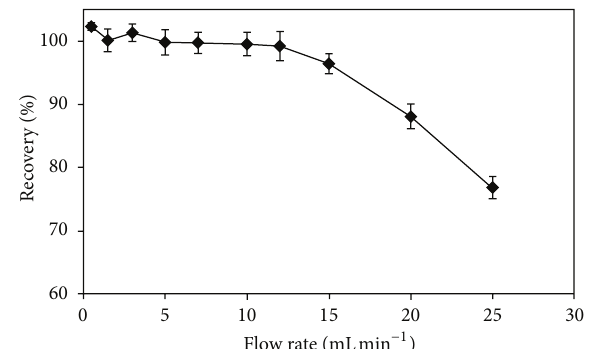
Figure 2: Effect of sample flow rate on the recovery of silver. Conditions: amount of silver 10 𝜇 g; sample volume 50 mL; pH ∼ 1.0; solvent for dissolving adsorbent DMF